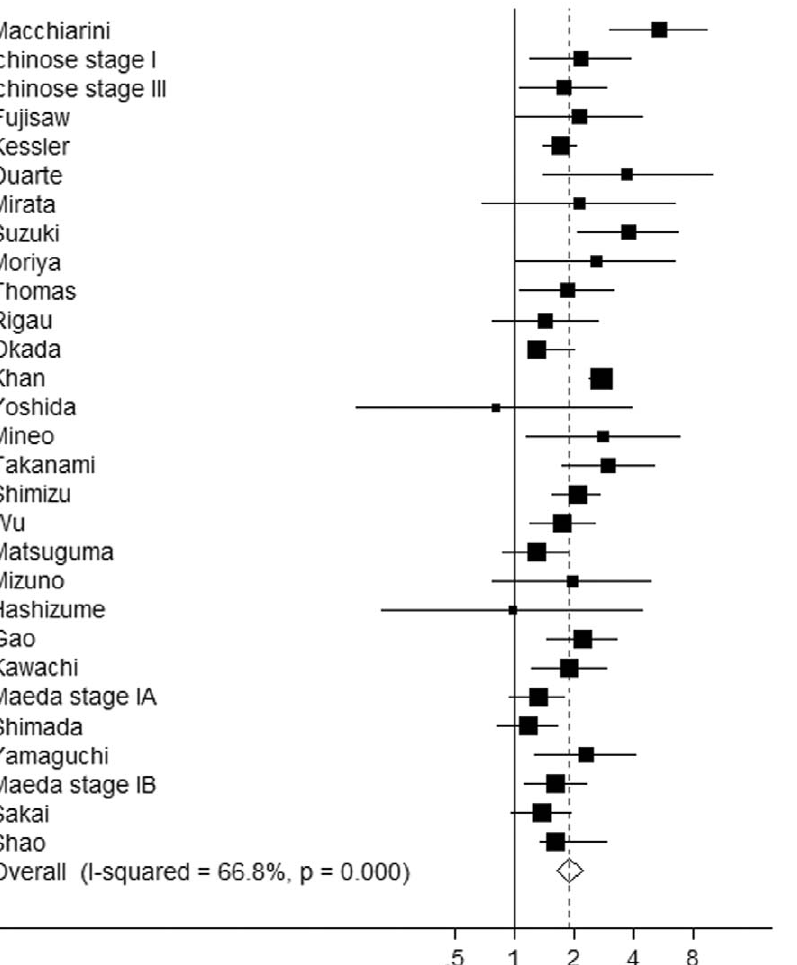
Figure 2. Forest plot showing the combined relative hazard ratio for overall survival in all patient populations by multivariate analysis. doi:10.1371/journal.pone.0028844.g002 PLoS ONE |